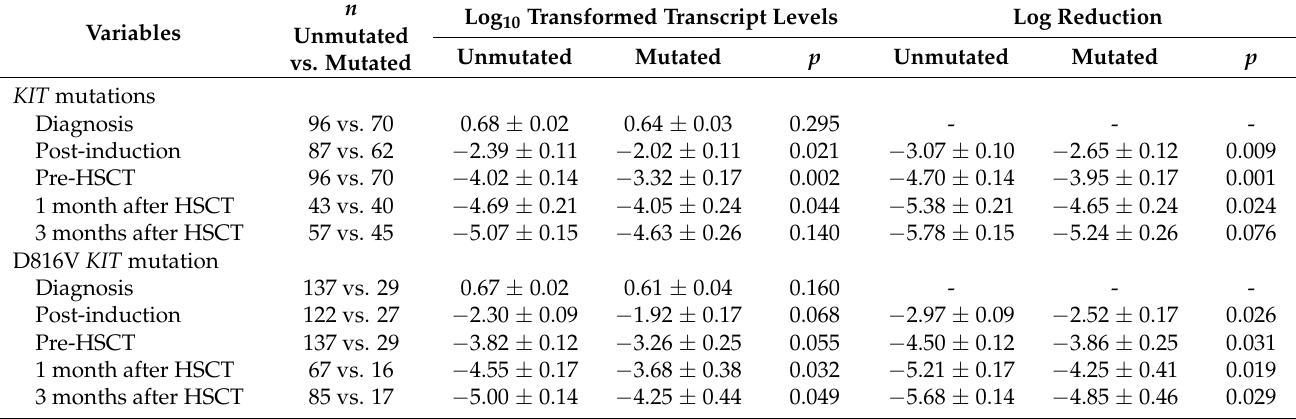
Table 2. Impact of KIT mutations on kinetics of RUNX1–RUNX1T1 transcript levels